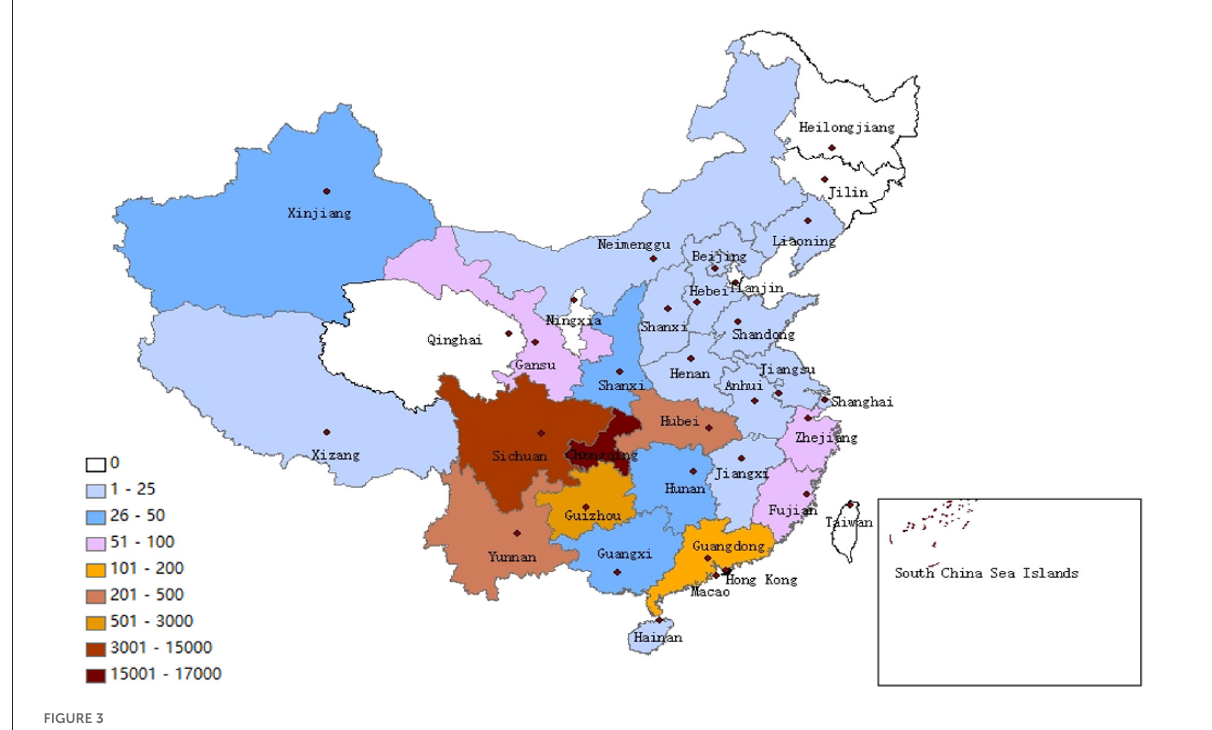
FIGURE3 Regional distribution of prescription deliveries.